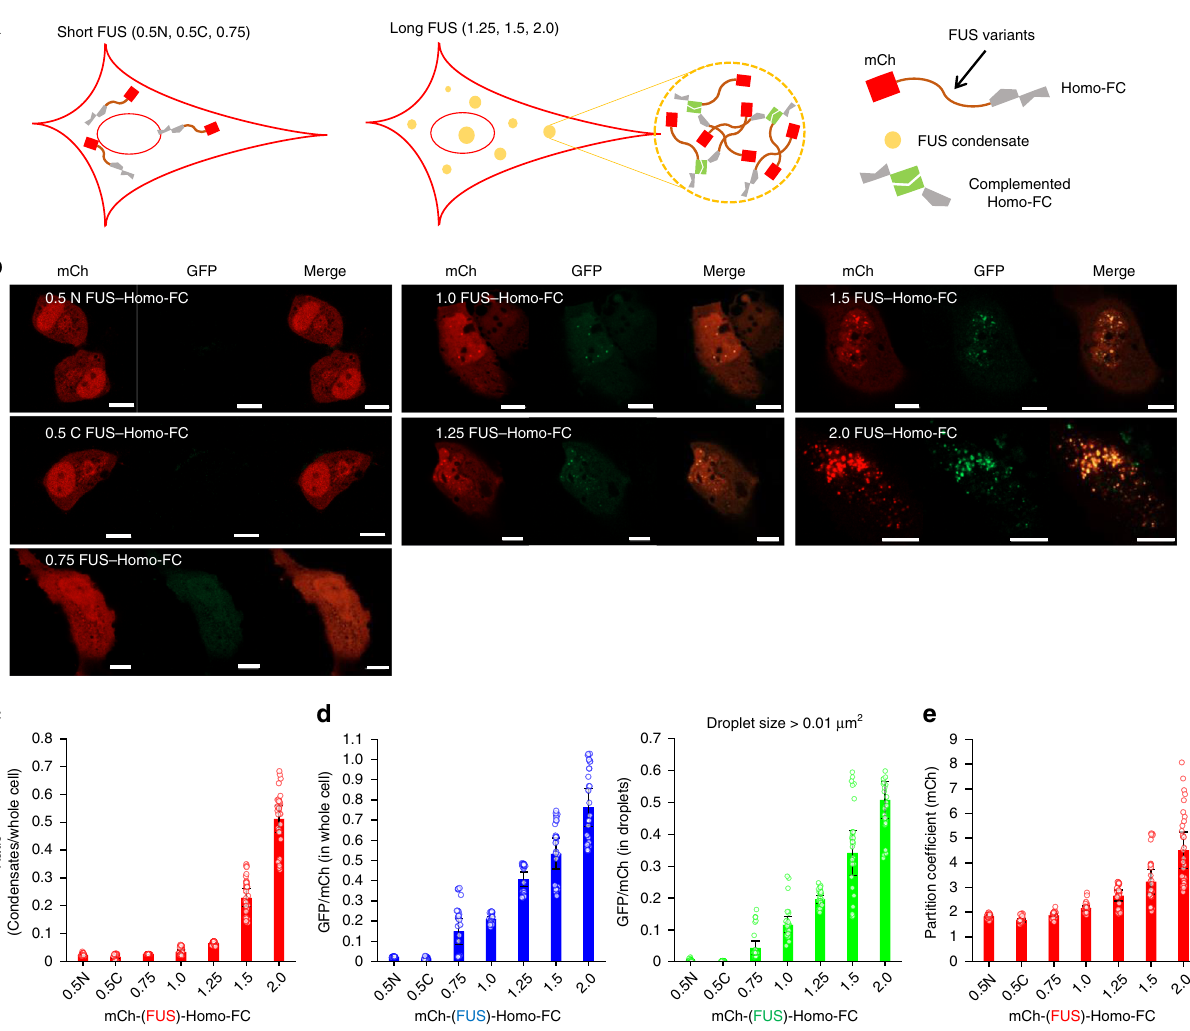
Fig. 2 Fluorescence complementation of scaffold-fused probes inside repeated-FUS compartments. a Schematic illustration of cellular condensate formation of long FUS constructs and FUS-fused Homo-FC probe complementation (green) inside FUS condensates. b Fluorescence (mCh and GFP) images of cells expressing mCh-FUS – Homo-FC proteins with varied FUS. Scale bars: 10 μ m. c Total mCh intensities of condensates (puncta sizes > 0.01 μ m 2 ) divided by whole cell mCh intensities for length-varied mCh-FUS – Homo-FC constructs. Data are presented as mean values with ±1 SD as error bars ( n = 33 cells from three independent experiments). d Total GFP (complemented Homo-FC)-to-mCh ratios in whole cells (left) or inside condensate droplets (right). Data are presented as mean values with ±1 SD as error bars ( n = 33 cells from three independent experiments). e mCh-FUS partition coef fi cients (PCs; mCh ratios inside/outside condensates). Although partition coef fi cients of all FUS variants are shown, condensates of short FUS variants (0.5 N, 0.5 C, 0.75 FUS) were rarely observed. Data are presented as mean values with ±1 SD as error bars ( n = 33 cells from three independent